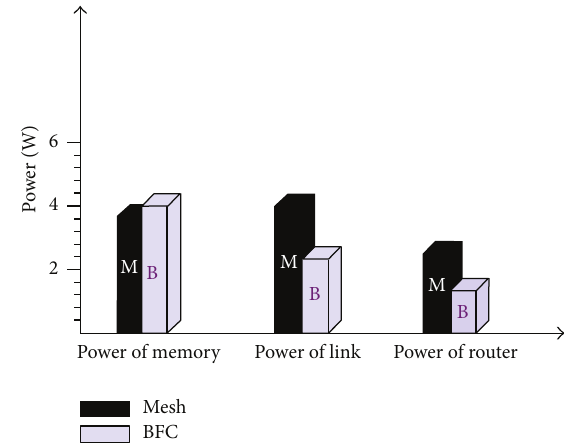
Figure 11: Comparison of two networks energy consumption.